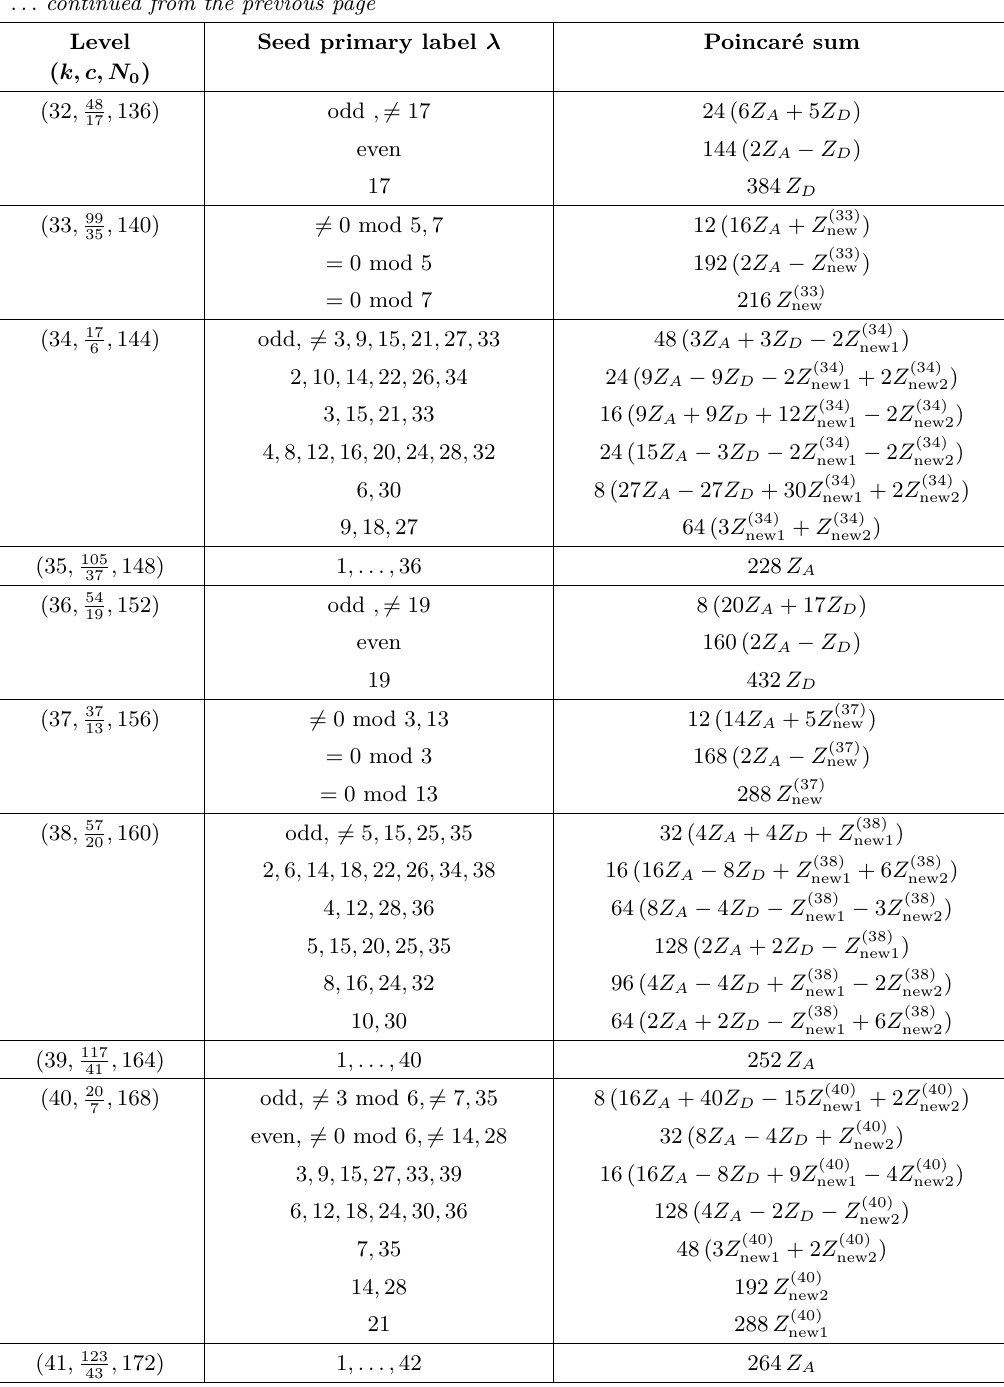
Table 7. Poincaré sums for SU(2) k